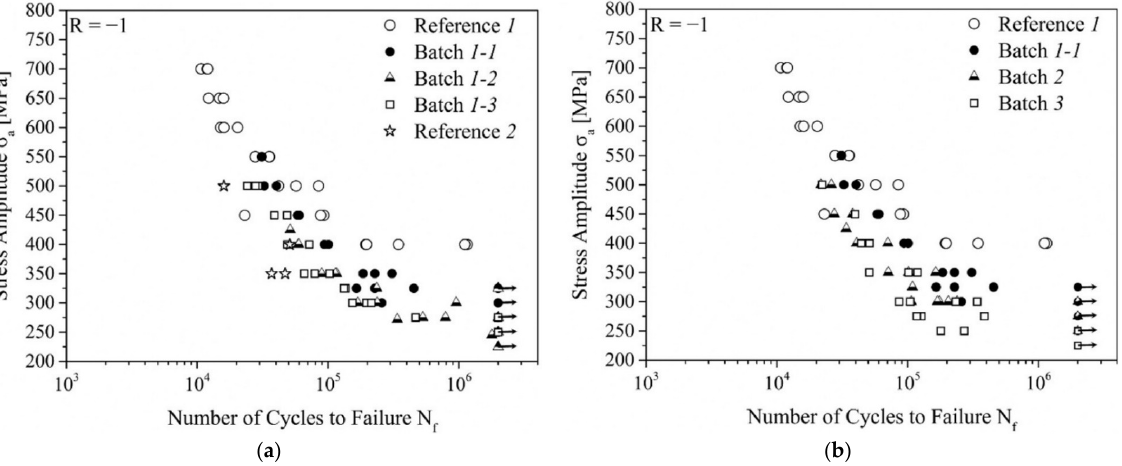
Figure 9. ( a ) S-N curves of batches with different internal channels as shown in Figure 8, partly recompiled from their previous studies [122]. ( b ) S-N curves with different batches compared to the results by Leuders et al. [123] and Kasperovich et al. [124] designated as Reference 1 and 2, re- spectively. Reprinted with permission from ref. [118]. 2018, Elsevier Ltd.